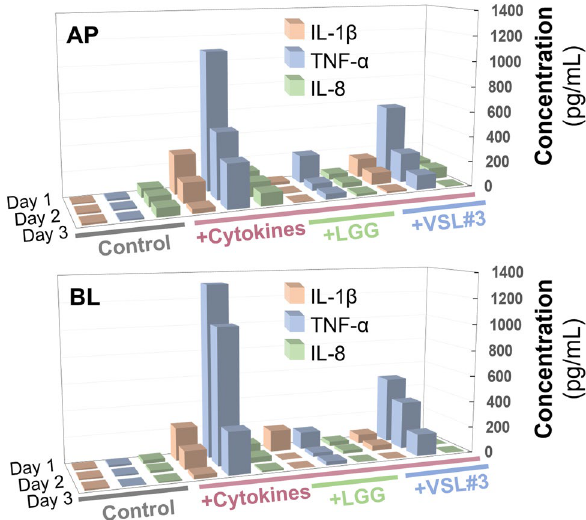
Figure 6. Extracellular secretion of pro-inflammatory cytokines, IL-1β, TNF-α, and IL-8, at various probiotic co-cultures on Days 1, 2, and 3. The colored lines indicate the group of samples that we assessed (Grey, Control; Red, + Cytokines; Green, + LGG + Cytokines; Blue, + VSL#3 + Cytokines). Samples were periodically collected from the apical (AP) or the basolateral compartment (BL), then quantitated. The concentration of secretory cytokines in the presence of probiotics (+ LGG + Cytikines or + VSL#3 + Cytokines) was significantly lower than those in the cytokine-challenged group (+ Cytokines) across the treated days in both compartments ( p < 0.05